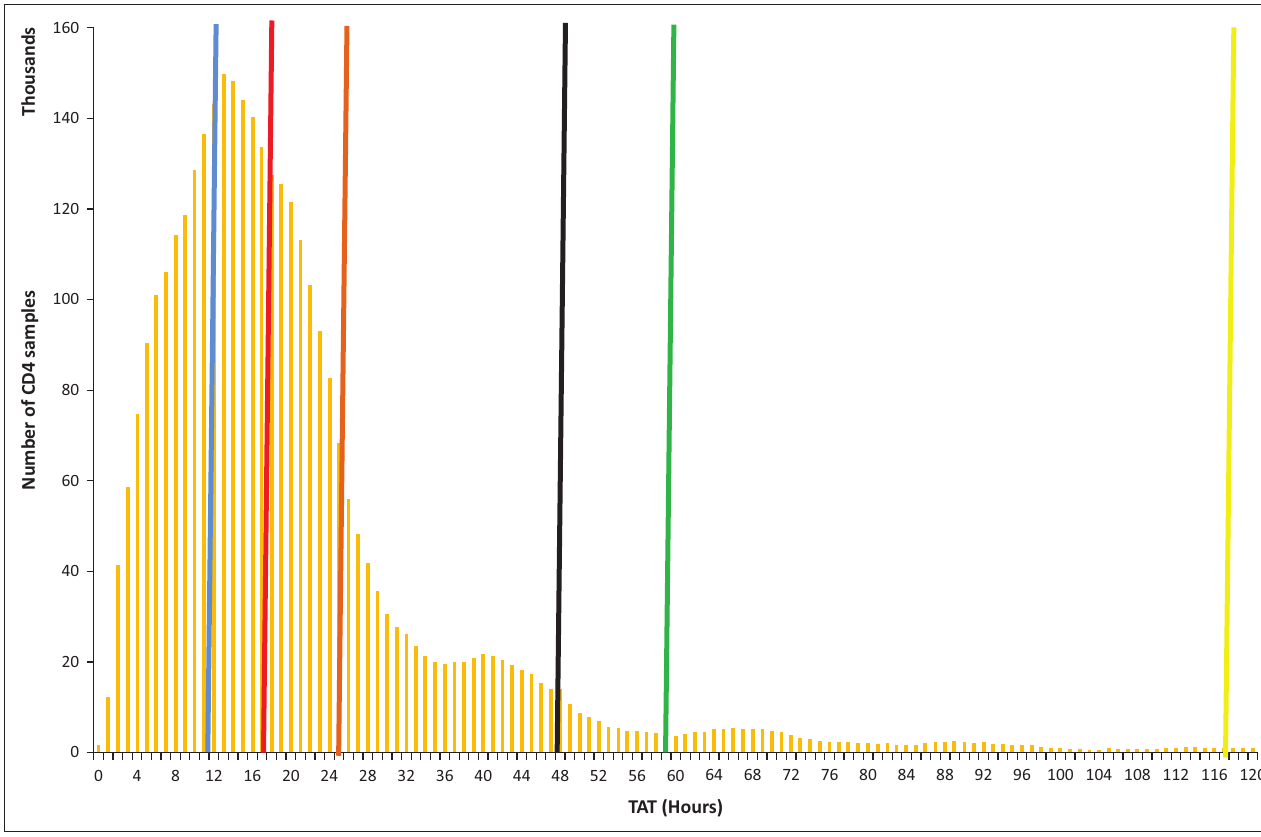
FIGURE 2: Histogram displaying turn-around time distribution across a national CD4 programme with the blue, red, orange, green and yellow lines representing the 25th, 50th (median), 75th, 95th and 99th percentiles, respectively, and the bold black line indicating the target turn-around time of 48